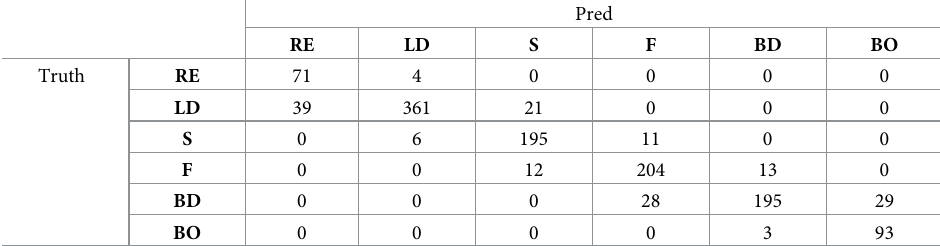
Table 7. Confusion matrix for the six principal phenological